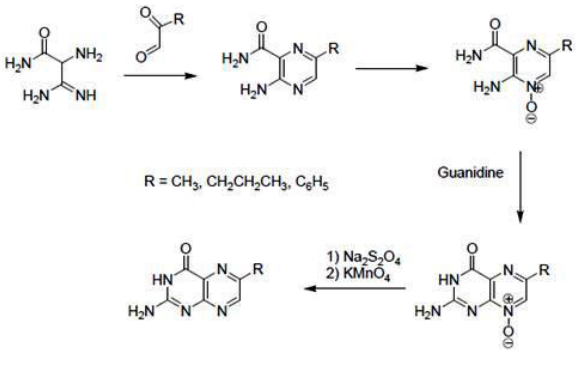
Figure 14: Taylor synthesis of